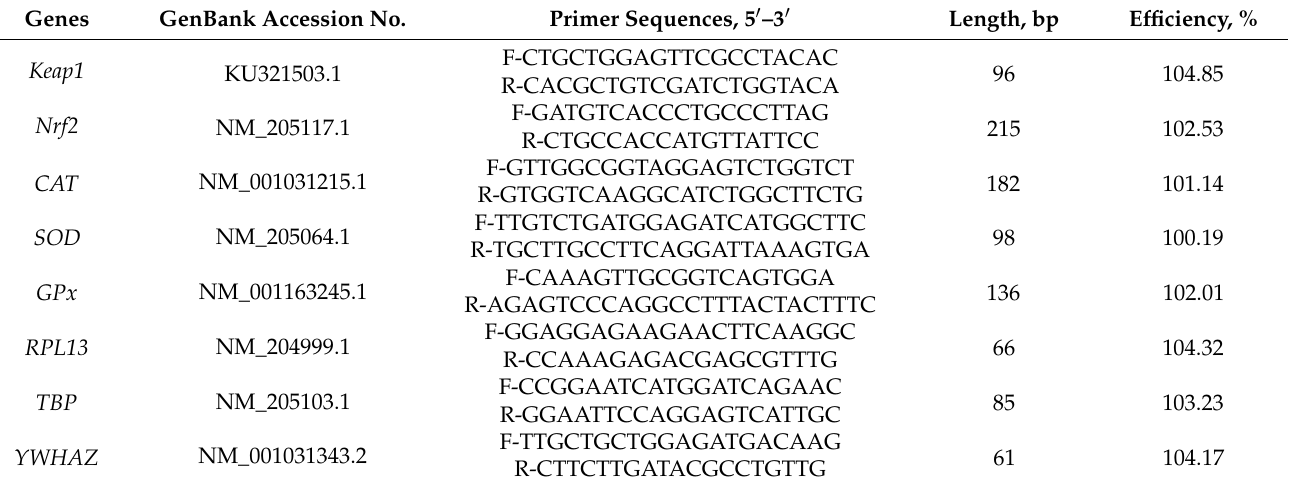
Table 2. Primer sequences and